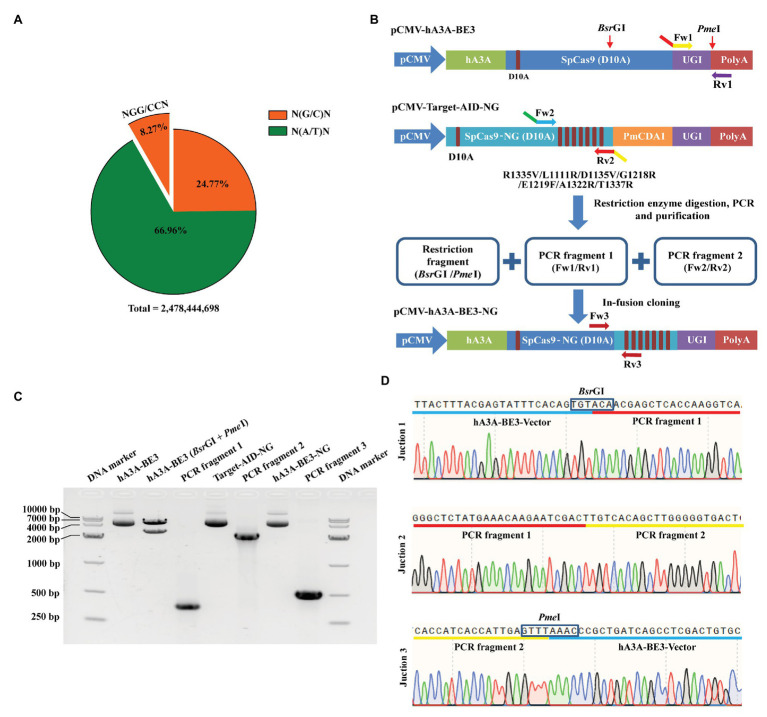
Construction of hA3A-BE3-NG vector for expanded targeting scope. (A) Pie chart shows the proportion of porcine genomic sites that can be targeted by SpCas9 or SpCas9-NG with distinct protospacer adjacent motif (PAM) specificities (NGG or NG). Pig reference genome (Sscrofa11.1) was used for analysis. (B) Schematic of the pCMV-hA3A-BE3-NG vector. Compared to SpCas9 (D10A) in hA3A-BE3, SpCas9-NG (D10A) in Target-AID-NG contained seven amino acids variants: R1335V, L1111R, D1135V, G1218R, E1219F, A1322R, and T1337R. hA3A-BE3-NG was constructed by in-fusion cloning of a restriction fragment digested via BsrGI and PmeI from hA3A-BE3, PCR fragment 1 amplified from hA3A-BE3 via Fw1/Rv1 primers, and PCR fragment 2 amplified from Target-AID-NG via Fw2/Rv2 primers. Overlapping sequences exist in the junction of the three different fragments. (C) The gel image indicates that hA3A-BE3 was digested into two fragments by BsrGI and PmeI. The PCR fragment 1 (387 bp) was amplified from hA3A-BE3 via Fw1/Rv1 primers, and the PCR fragment 2 (2,556 bp) was amplified from Target-AID-NG via Fw2/Rv2 primers. The large fragment (5,570 bp) from hA3A-BE3, PCR fragment 1 and PCR fragment 2 were fused into a recombinant vector, hA3A-BE3-NG, which was confirmed by a PCR product (540 bp) amplified via Fw3/Rv3 primers. (D) The chromatograms of Sanger sequencing show the junctional sequence was accurate among the above three fragments in recombinant hA3A-BE3-NG.